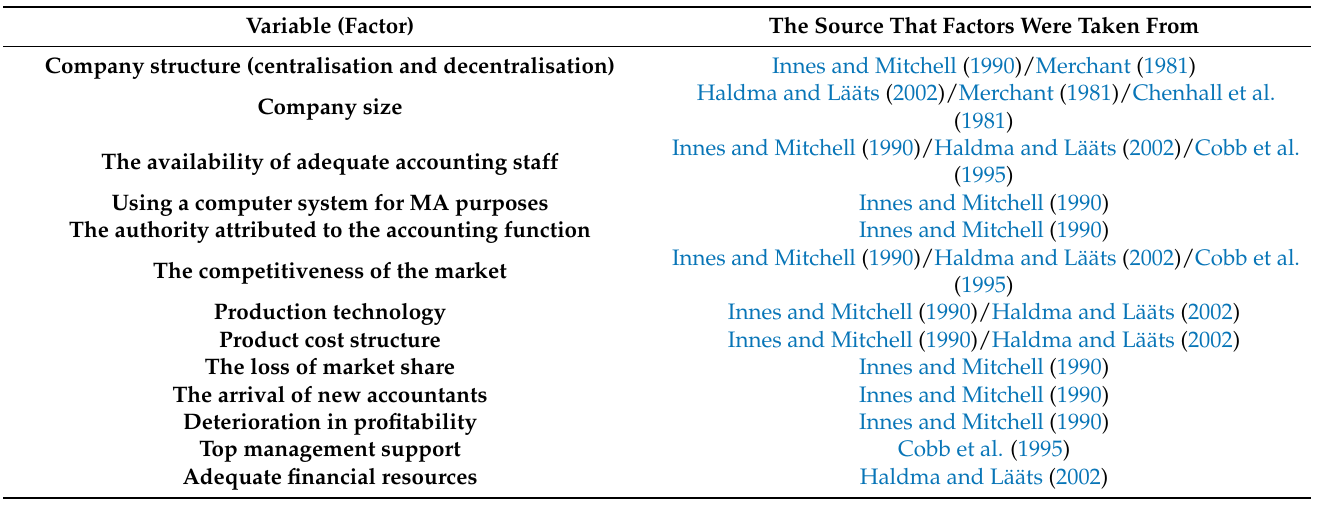
Table 1. Contingent